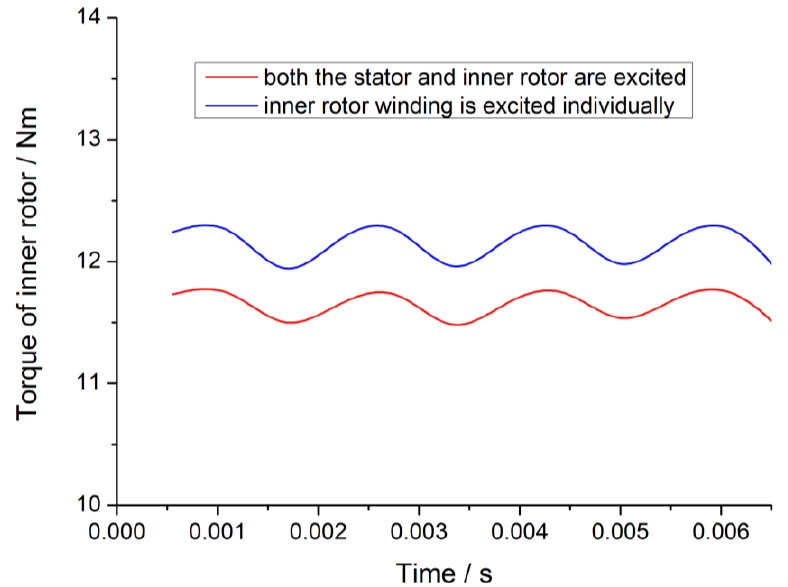
Figure 22. The torque waveforms of the inner rotor in different